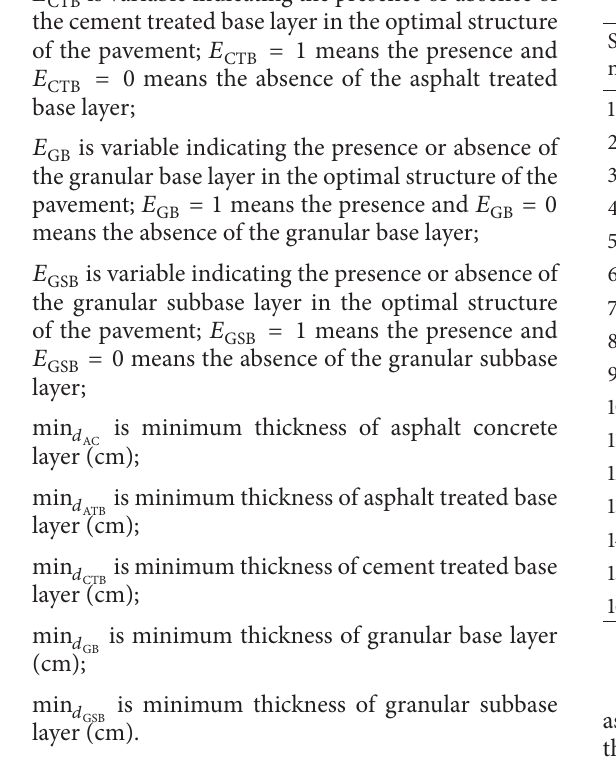
Table 3: Different alternatives for pavement